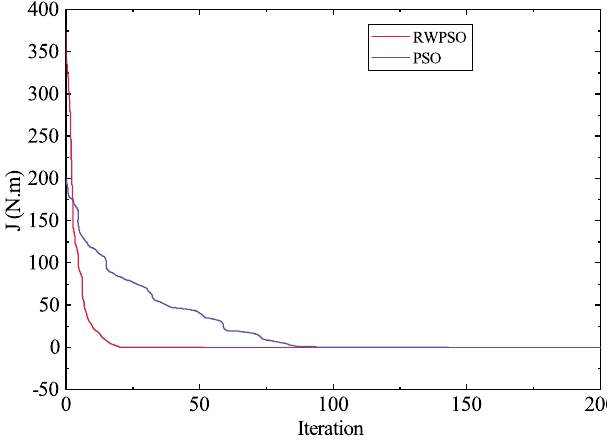
Figure 4. Iteration curves of two